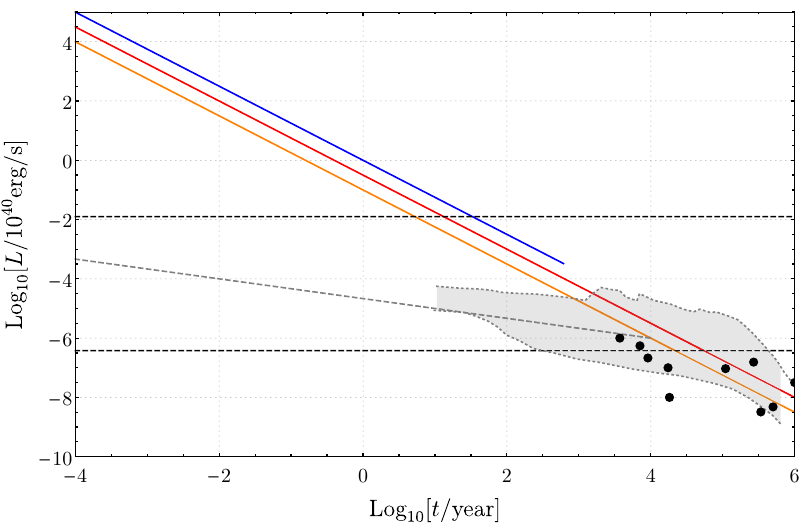
Figure 6 . Power emitted by the gas inside of bubbles of different maximal size as a function of time. The blue, red and orange solid lines correspond to bubbles with a maximal size of 1, 10 and 100 light seconds, respectively. The grey dashed line shows the thermal power of a neutron star cooling dominantly by emission of neutrinos in the neutron star core, while the gray shaded region shows the power of thermal emission during subsequent cooling of the neutron star by photon emission in different environments [57, 59]. The black dots represent the observed power for some of the known neutron stars. The black dashed lines shows the Eddington luminosity of a solar mass blackhole and the solar luminosity (top and bottom